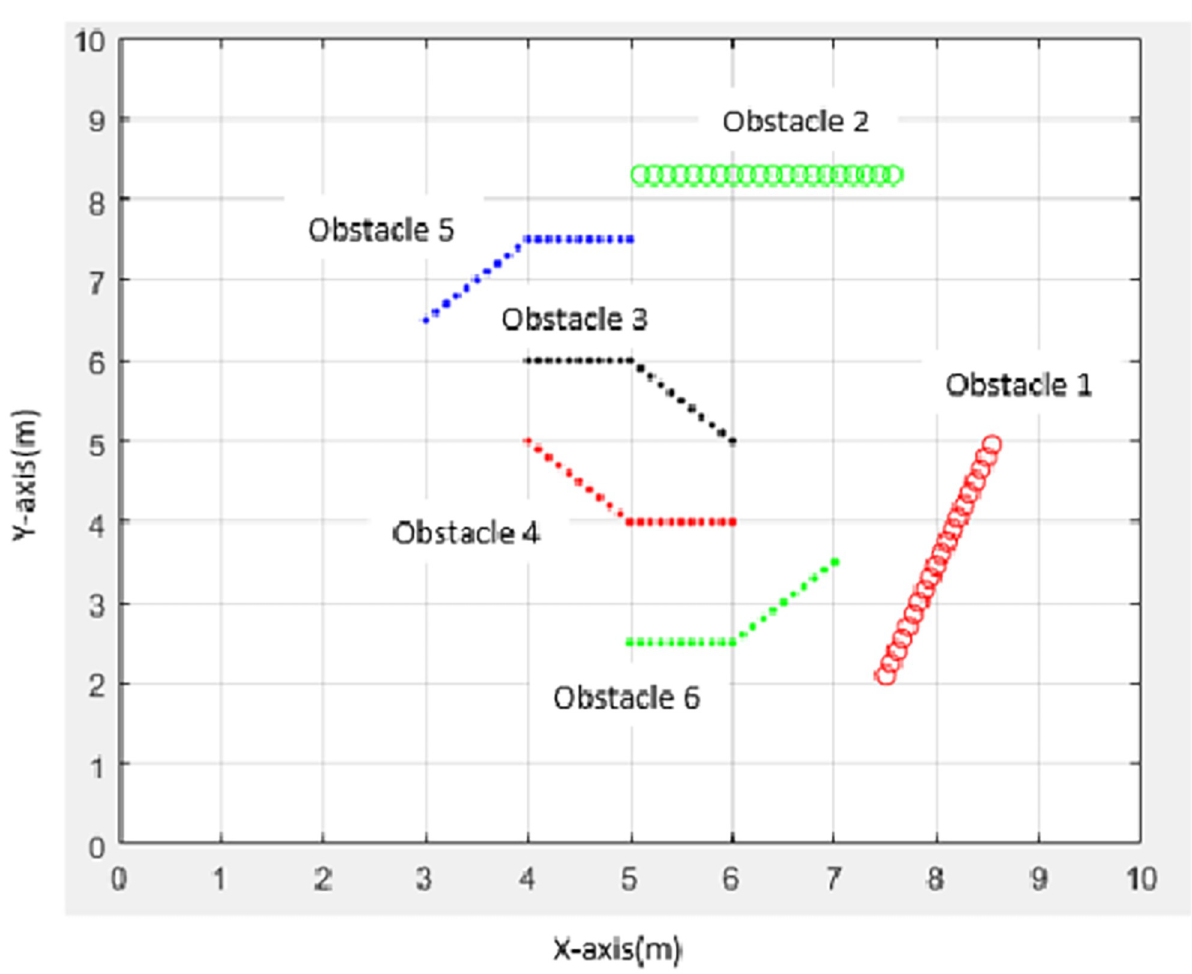
Fig 8. The movement of each obstacle in a dynamic